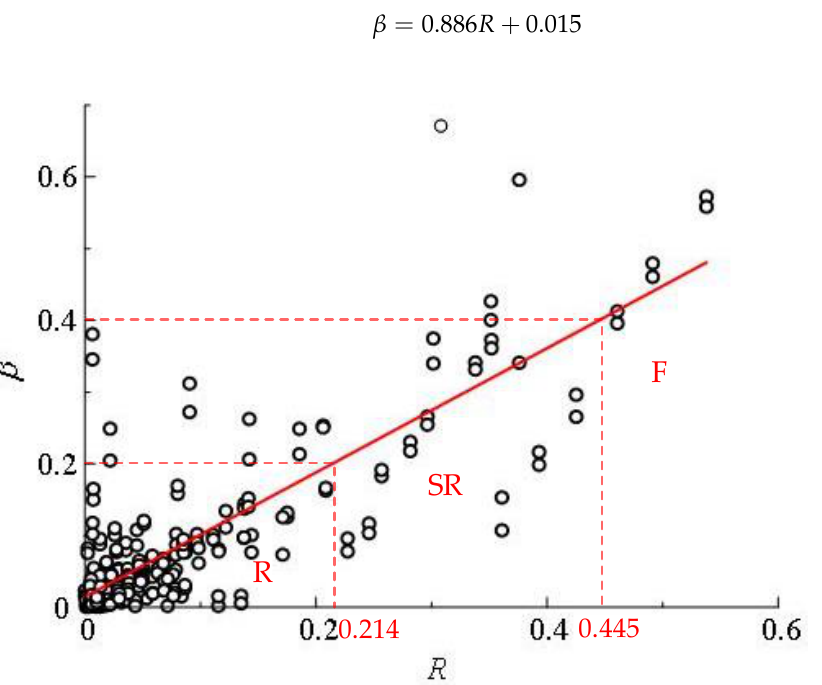
Figure 12. Regression analysis of internal force amplification factor.